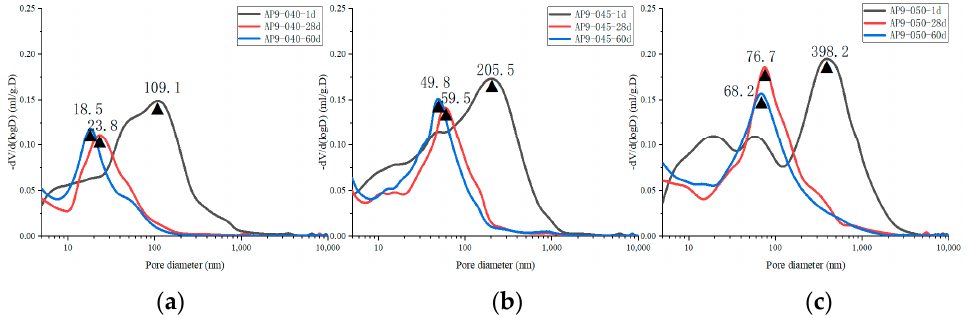
Figure 16. The pore size distribution of hydrated AS-accelerated cement pastes with different w/c: